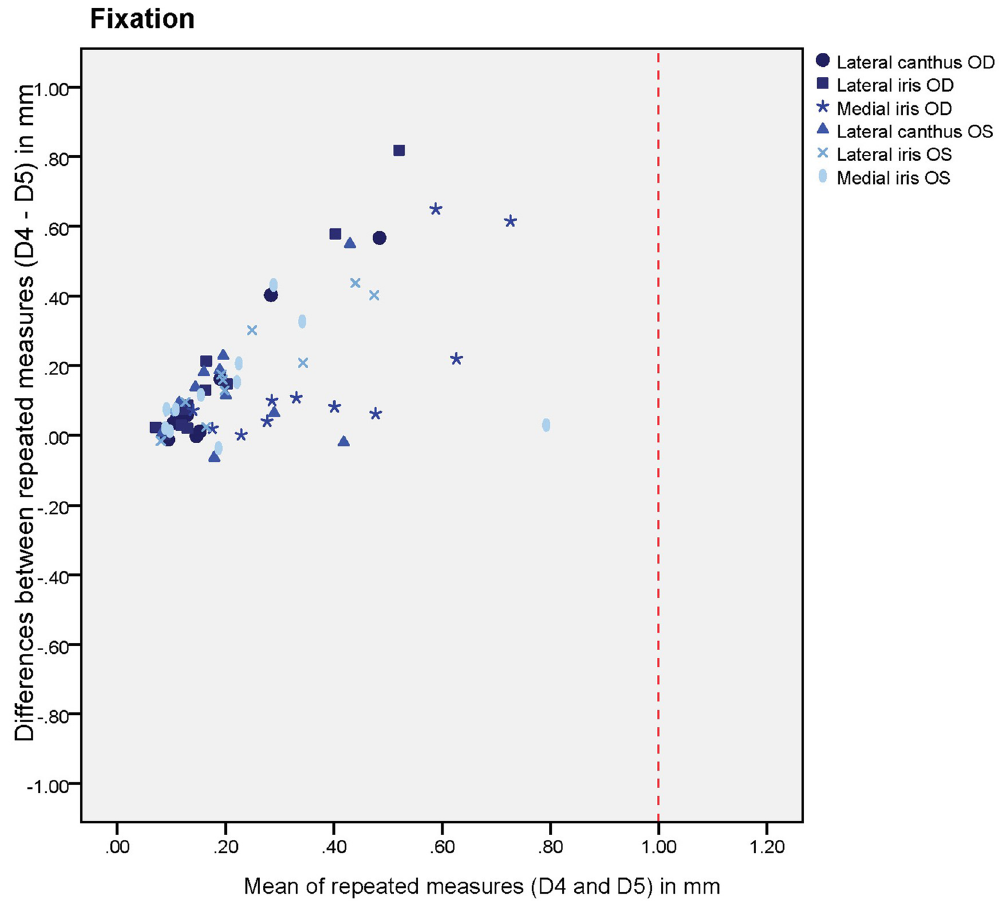
Figure 7. Systematic differences of different anatomical sites after scanning the head in a fixed position. Differences between the first minute-interval deviations and second minute-interval deviations were computed by the following subtraction: first minute-interval deviations (D4) – second minute-interval deviations (D5). OD oculus dexter (right eye), OS oculus sinister (left eye). The red intermittent line shows the clinical 1 mm mean deviation cut-offs in subsequent scans. All the mean deviations were below this